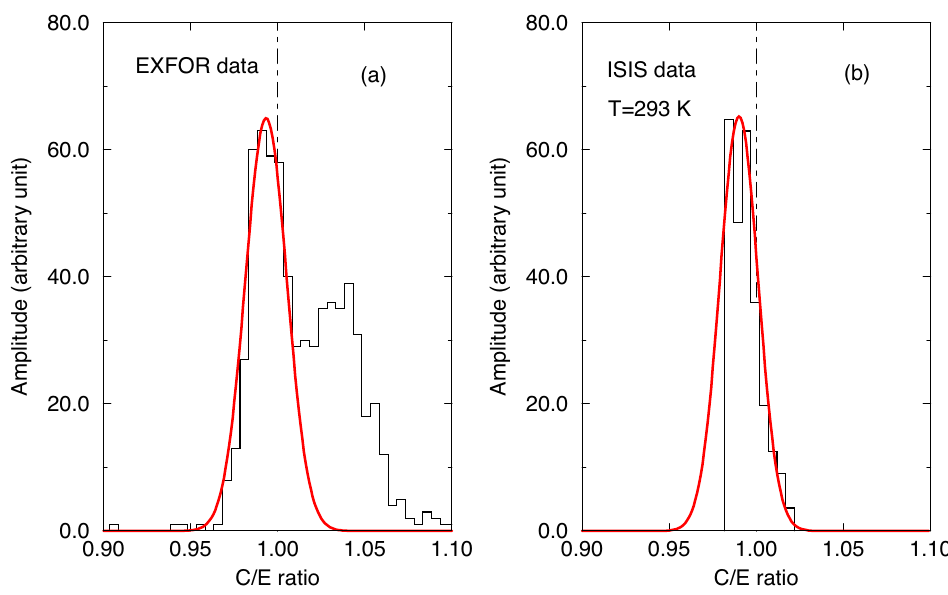
Fig. 7. Distributions of the ratios of the theoretical total cross-section of H 2 O (C) to the experimental data (E). The theoretical curves were calculated with the JEFF-4T1 evaluation of H 2 O.